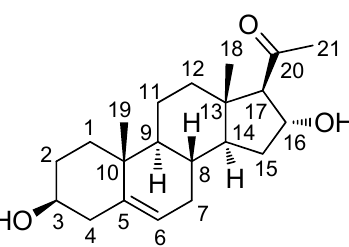
Figure 1. Structure of (3 β ,16 α )-3,16-dihydroxypregn-5-en-20-one ( 1 ).